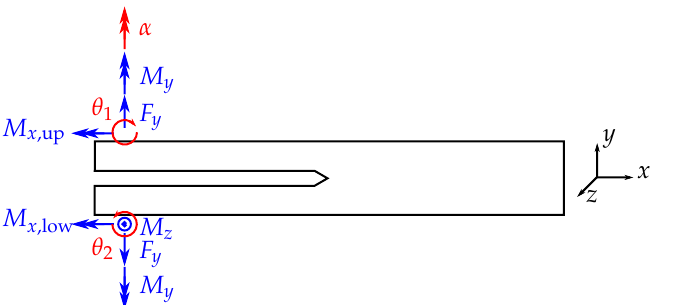
Figure 2. Schematic drawing of a loaded specimen. Measured forces and moments are displayed in blue color; measured or prescribed rotations are displayed in